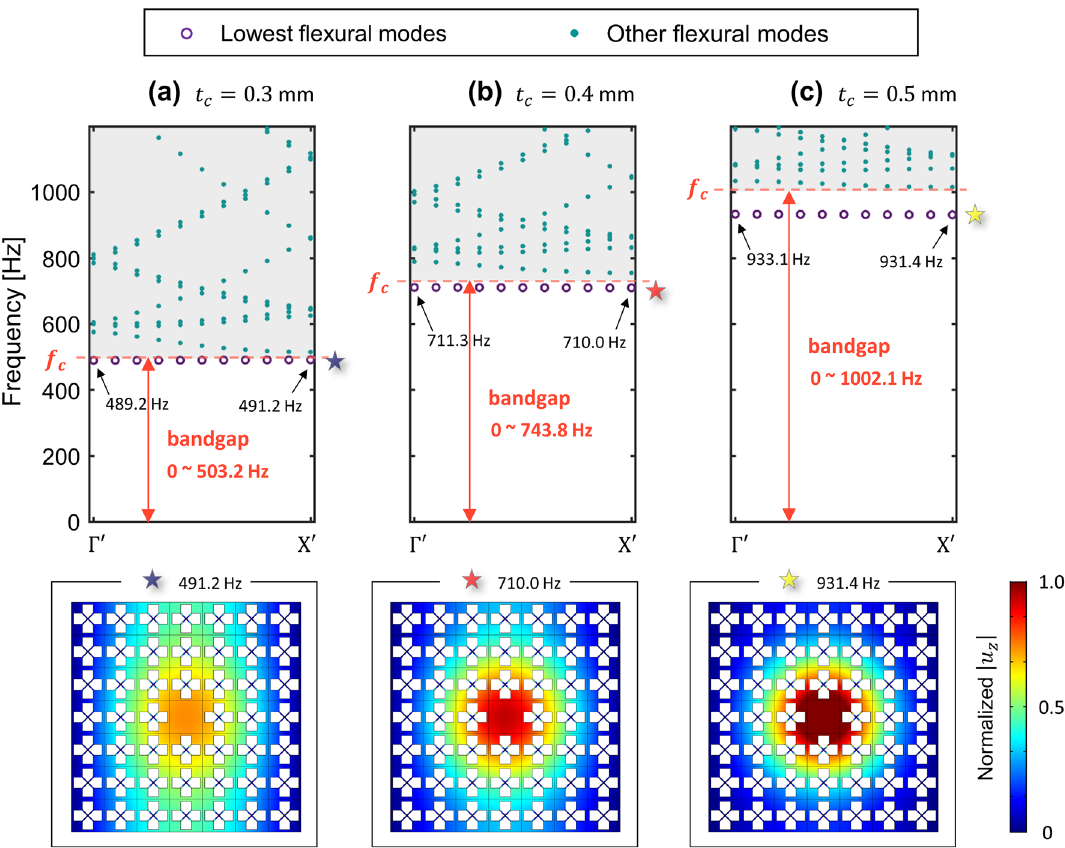
Figure 6. Localized wave from the supercell analysis. t c is ( a ) 0.3 mm, ( b ) 0.4 mm and ( c ) 0.5 mm.